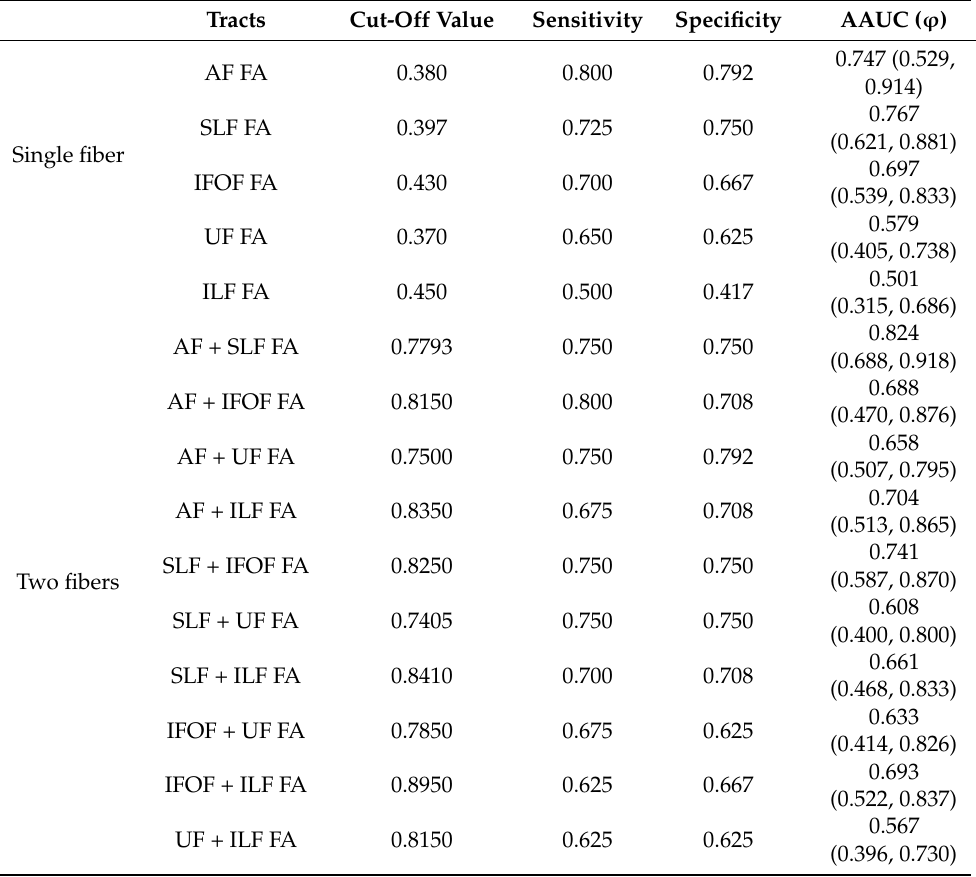
Table 2. ROC curve analysis according to aphasia severity.